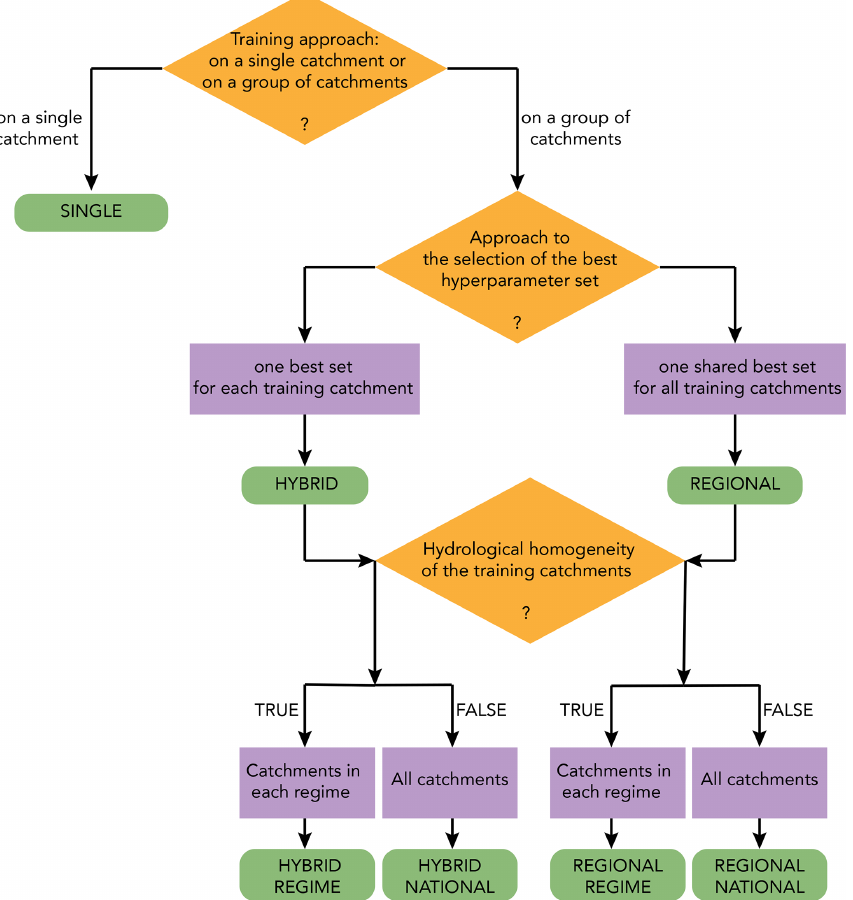
Figure 8. Conceptual flowchart of how SINGLE, REGIONAL, and HYBRID LSTM models and their submodels (green rounded rectangles) are built based on three decision criteria (orange rhombuses): the training approach, the approach to the selection of the best hyperparameters, and the training